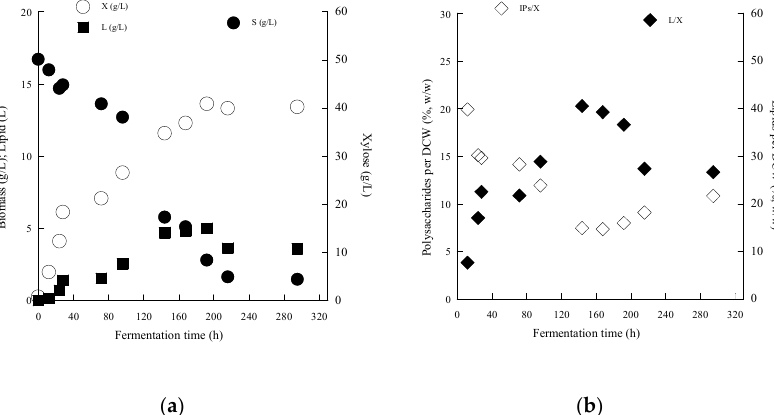
Figure 2. Kinetics of ( a ) biomass (X, g/L) and lipid (L) production as well as xylose consumption and ( b ) polysaccharides in DCW (% w / w ) and lipids in DCW (% w / w ) during shake-flask fermentations of R. toruloides NRRL Y-27012 when 20 g/L of lignosulphonates (LS) were applied in shake-flask nitrogen-limited media. The culture conditions were: 250 mL Erlenmeyer flasks filled up to 50 mL at 180 rpm, initial pH = 6.0, pH ranging between 5.2 and 5.8, incubation temperature T = 28 °C, initial sugar concentration ca. 50 g/L. Each experimental point is the mean value of two independent meas- urements.